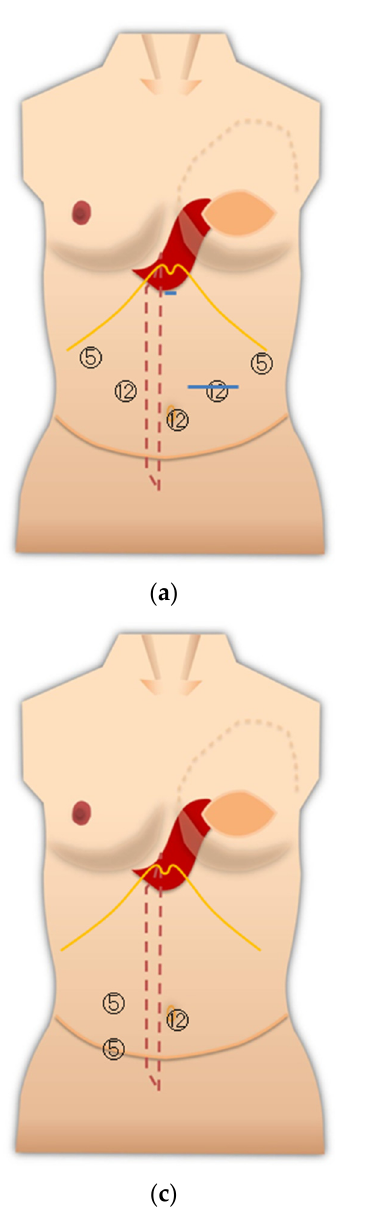
Figure 4. ( a ) Port layout of Case 4 during gastrectomy. The blue line is an incision line; ( b ) view of the abdominal cavity after intestinal anastomosis; ( c ) port layout during ileus reduction surgery; ( d ) working space was adequate. When performing laparoscopic cholecystectomy, the port was inserted with careful attention to the folded portion of the TRAM in the epigastric area. The upper abdominal field of view was good (Figure